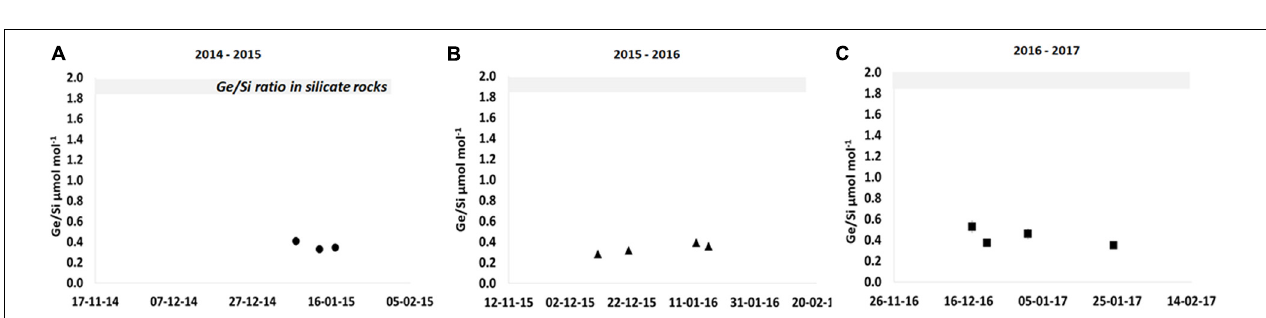
FIGURE 3 | Dissolved silicon concentrations in < 0.4 µ m filtered water from Crescent Stream. Samples were collected between December and February 2014–2015 (A) ; 2015–2016 (B) ; 2016–2017 (C) .